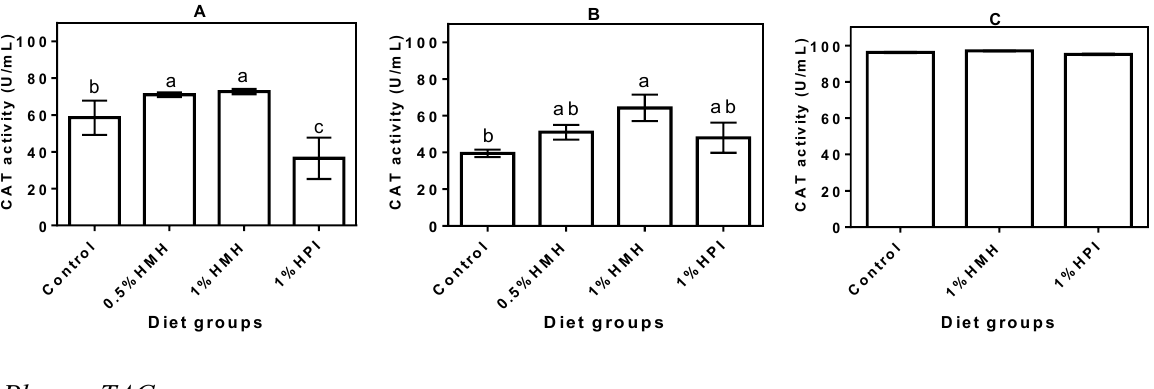
Figure 3. Catalase (CAT) activity in plasma of ( A ) young growing spontaneously hypertensive rats (SHRs) (Trial I), ( B ) adult SHRs with established hypertension (Trial II) and ( C ) normotensive rats (Trial III) with a casein-only diet or casein diet that contained hemp seed meal protein hydrolysate (HMH) or hemp seed protein isolate (HPI). Bars with different letters have mean values that are significantly different ( p < 0.05). Values are means ( n = 4 rats) ±